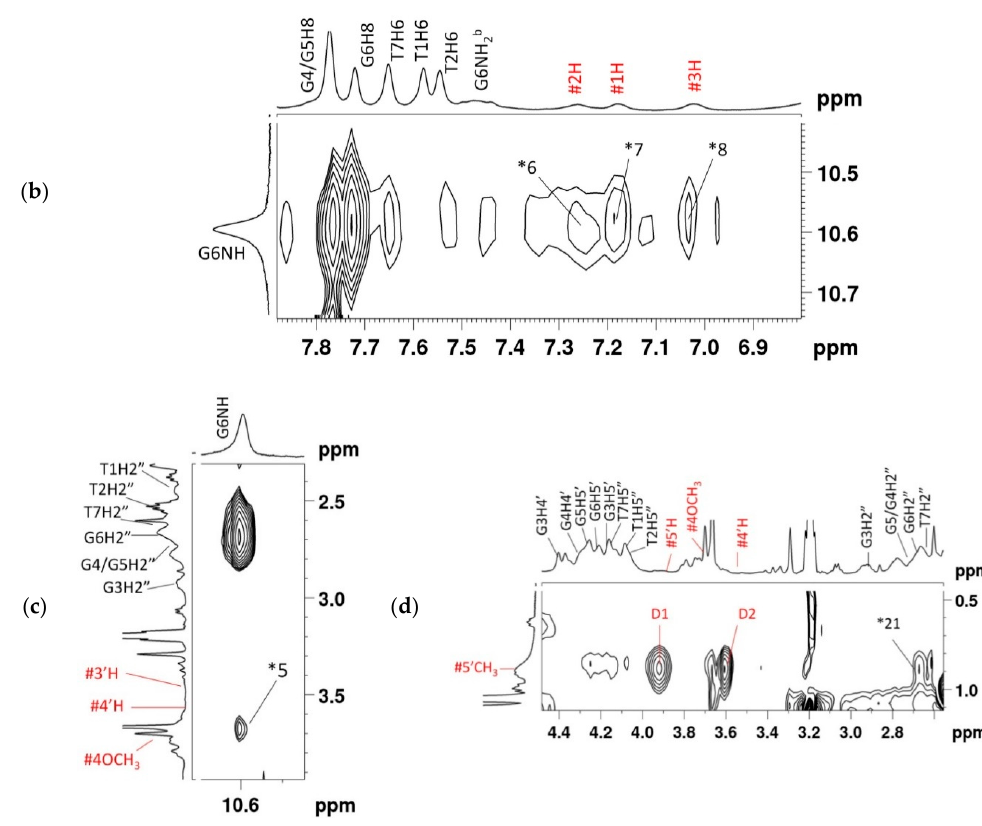
Figure 6. 2D 1 H- 1 H Nuclear Overhauser Enhancement SpectroscopY (NOESY) spectra of daunomycin-[d-(TTGGGGT)] 4 complex at D/N = 2.0, mixing time τ m = 250 ms, at 25 °C. Expansion of specific regions of NOESY spectra showing NOE (Nuclear Overhauser Enhancement) correlations between ( a ) daunomycin protons 1H, 2H, 3H, 5 ′ CH 3 , 3 ′ H, 4 ′ H, and 4OCH 3 , and H8/H6/H1 ′ /H2 ′ /H2 ′′ /CH 3 protons along with intramolecular NOE cross-peaks of daunomycin (D); ( b ) Daunomycin protons 1H, 2H, 3H, and imino proton, ( c ) daunomycin proton 4OCH 3 and imino proton; and ( d ) Daunomycin proton 5 ′ CH 3 and sugar H2 ′′ proton along with intramolecular NOE cross-peaks of daunomycin (D). Symbol # denotes daunomycin protons, D denotes intramolecular cross-peaks of daunomycin (D numbering as in Table S3), and * denotes intermolecular cross-peaks between daunomycin and DNA [d-(TTGGGGT)] 4 protons (* numbering as in Table 3).